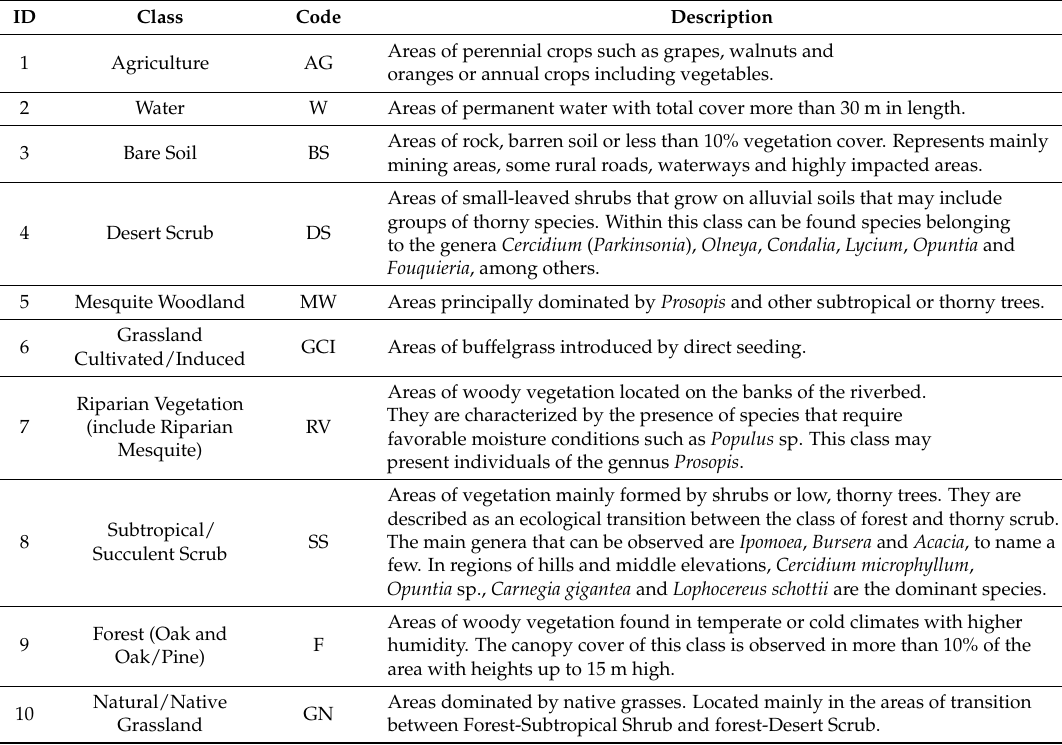
Table 2. Description of the types of land use–land cover used for the classification